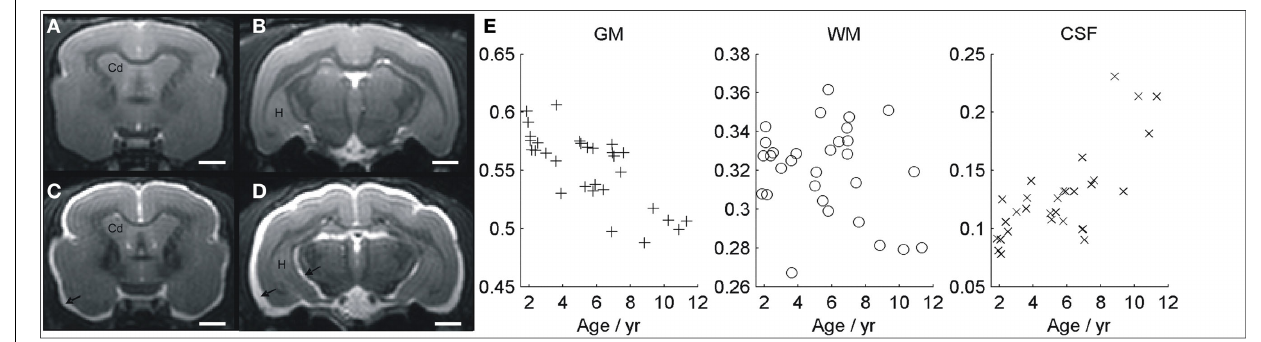
older animal (arrows). The evolutions of gray matter, white matter, and CSF volumes, evaluated with voxelwise studies, are shown in (E) . Cd, caudate nucleus; H, hippocampus. Scale bars = 2mm.